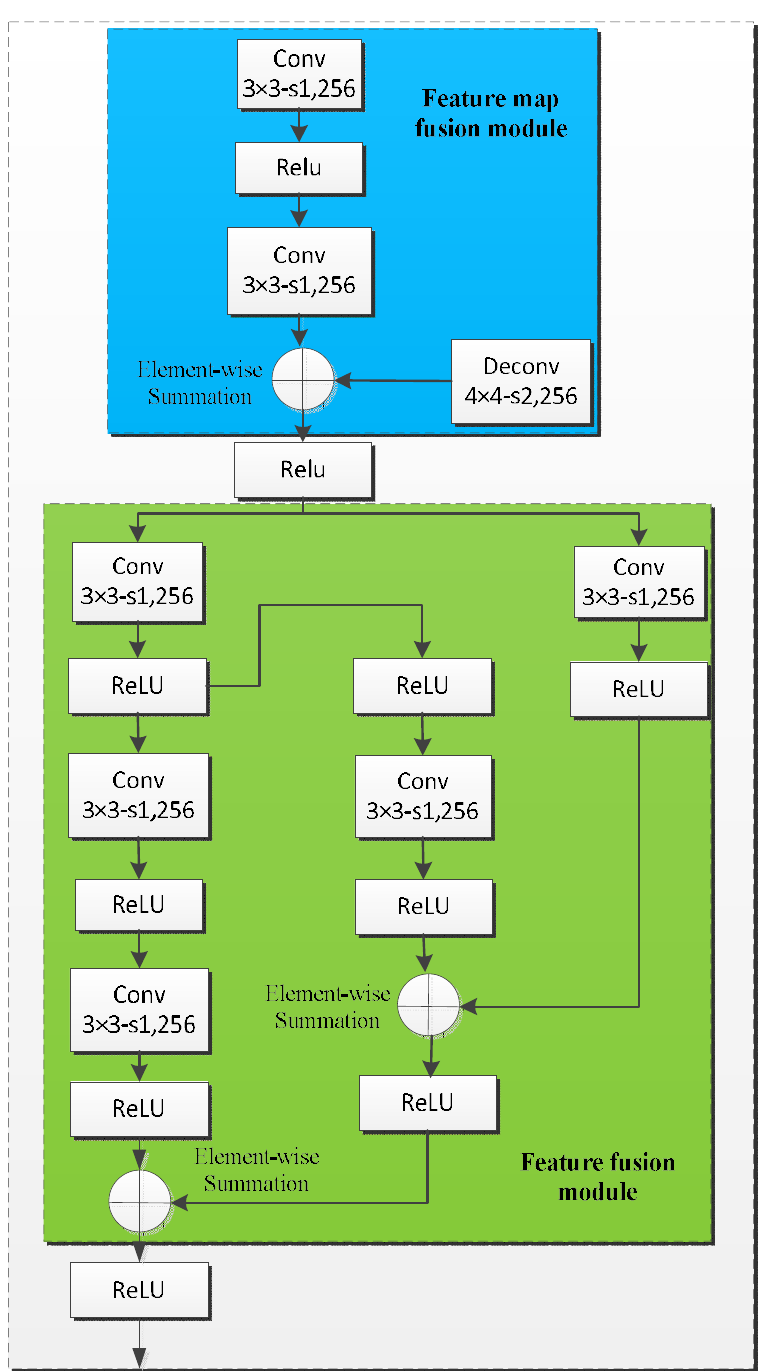
Figure 5. Object detection module.